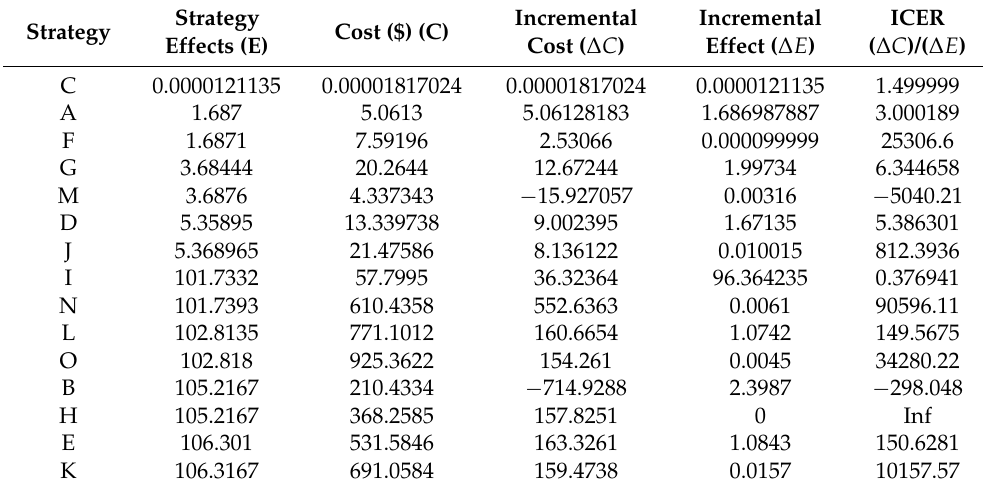
Table 7. Incremental cost-effectiveness ratios of all combined strategies for Endemic region.